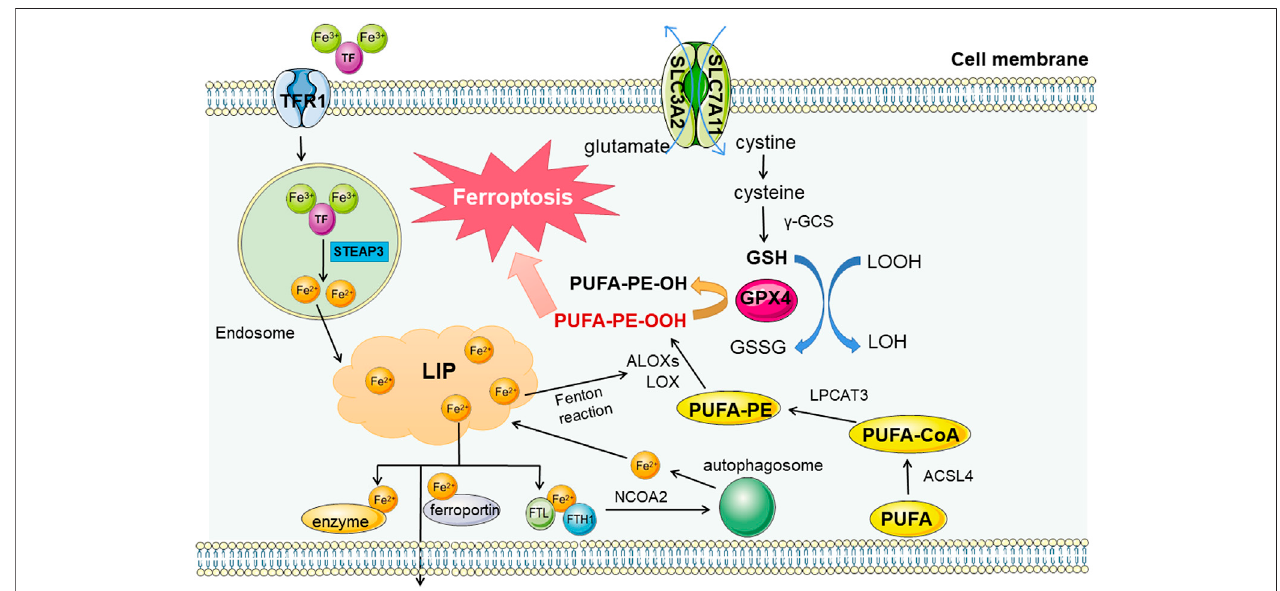
FIGURE 1 | Regulation pathways in ferroptosis. There are three main metabolic pathways related to ferroptosis, iron metabolism, lipid metabolism and amino acid metabolism. The fi rst two metabolites mainly promote the occurrence of ferroptosis, while the metabolites of amino acids (taking cysteine as an example) mainly play a roleinresistingmaterial peroxidation and ferroptosis. Fe 3+ entersthecellthroughtransferrin receptor 1(TFR1)and isreducedtoFe 2+ inlysosome.Afterentering thefree ironpool,itcanpromotetheformationanddestructionoflipidperoxides,andhindertheremovalofiron(includingsynthase,expellingandbindingtoferritinstorage) can lead to the overload of free iron. In addition, lipid peroxidation products are affected by Acyl-CoA synthetase long-chain family member 4 (ACSL4), lysophosphatidylcholineacyltransferase3(LPCAT3),Arachidonicacidlipoxygenases(ALOXS)andotherenzymes,andarealsocatalyzedbyFe2+Fentonreaction.Lipid peroxides produced have a central position in the process of ferroptosis. As a representative of antioxidant capacity, cysteine metabolic pathway can reduce lipid peroxides by Reduced glutathione (GSH). The coordination of the three maintain the stability of the internal environment, and the collapse of the balance will lead to the cascade reaction of